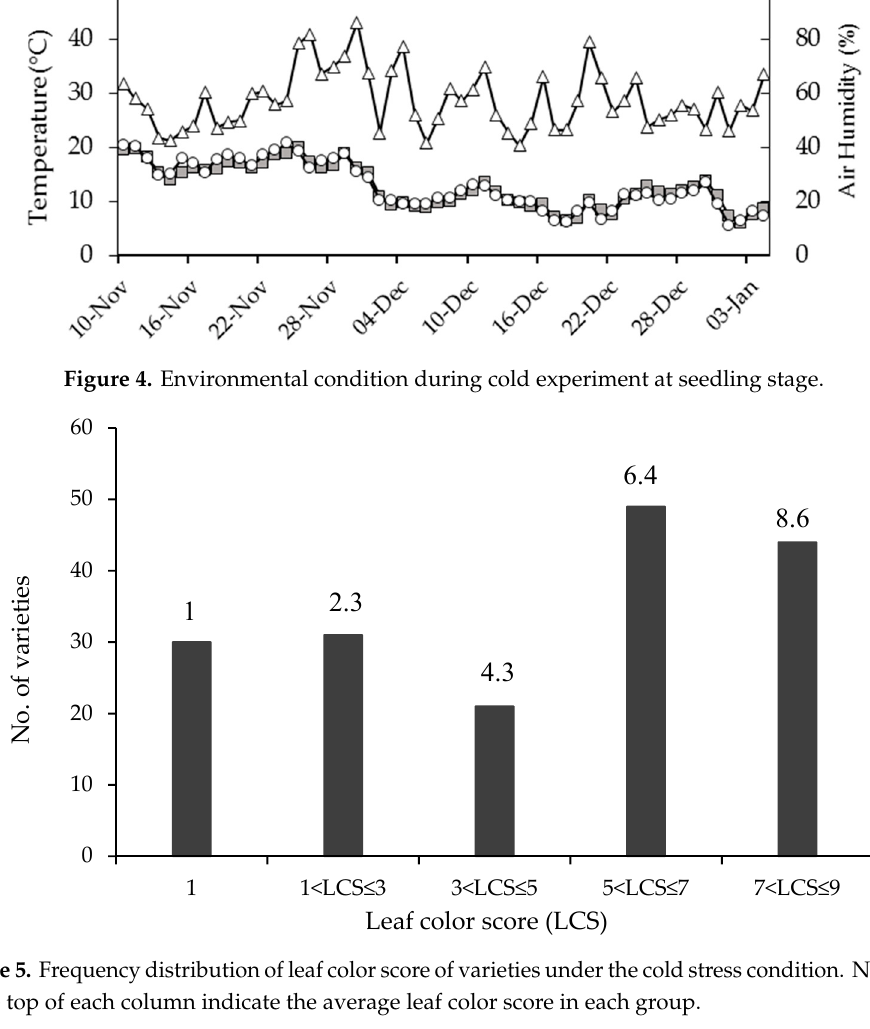
Figure 4. Environmental condition during cold experiment at seedling stage.